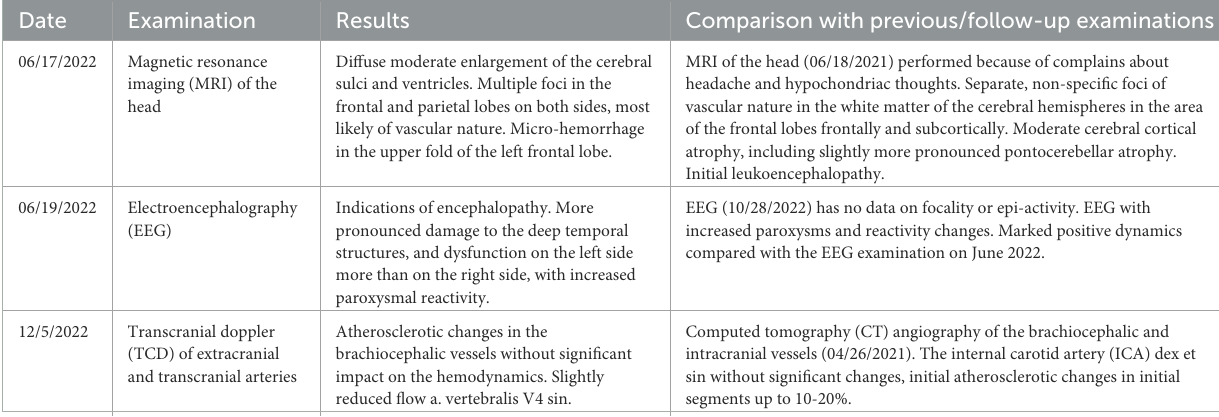
TABLE 1 The results of examinations performed in an outpatient setting and a neurological day hospital. Examination Results Comparison with previous/follow-up